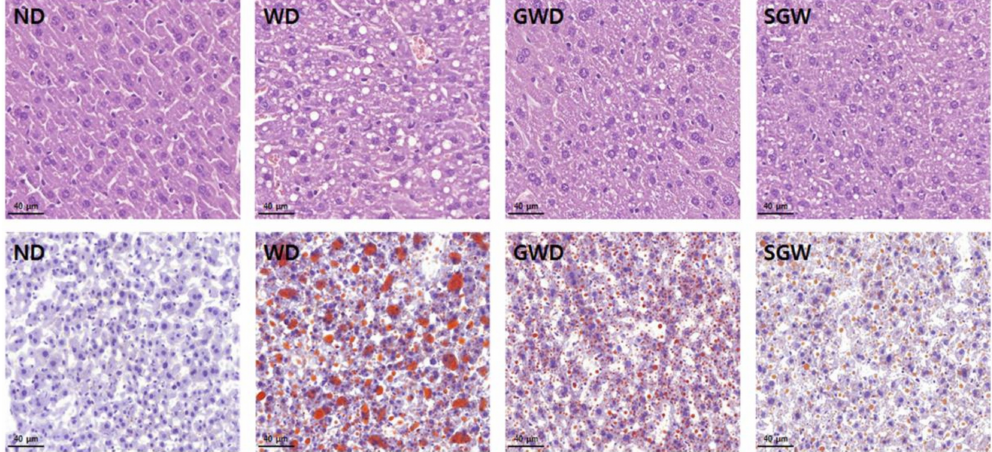
Figure 6. Diet-induced histological changes in liver. Representative histological results by hematoxylin and eosin (upper) and oil red O (lower)